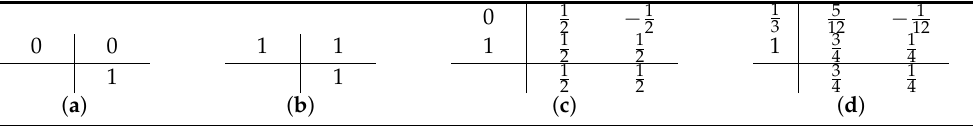
Table 1. Butcher tableau for ( a ) explicit Euler or Landweber, ( b ) implicit Euler or